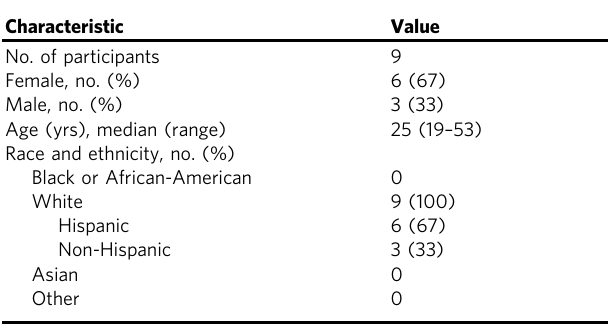
Table 1 Demographics of study participants testing